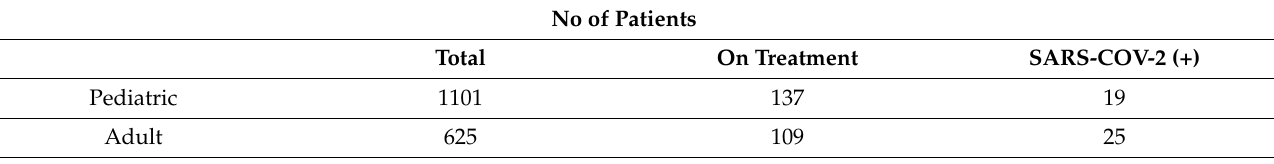
Table 1. Patients and healthcare units.